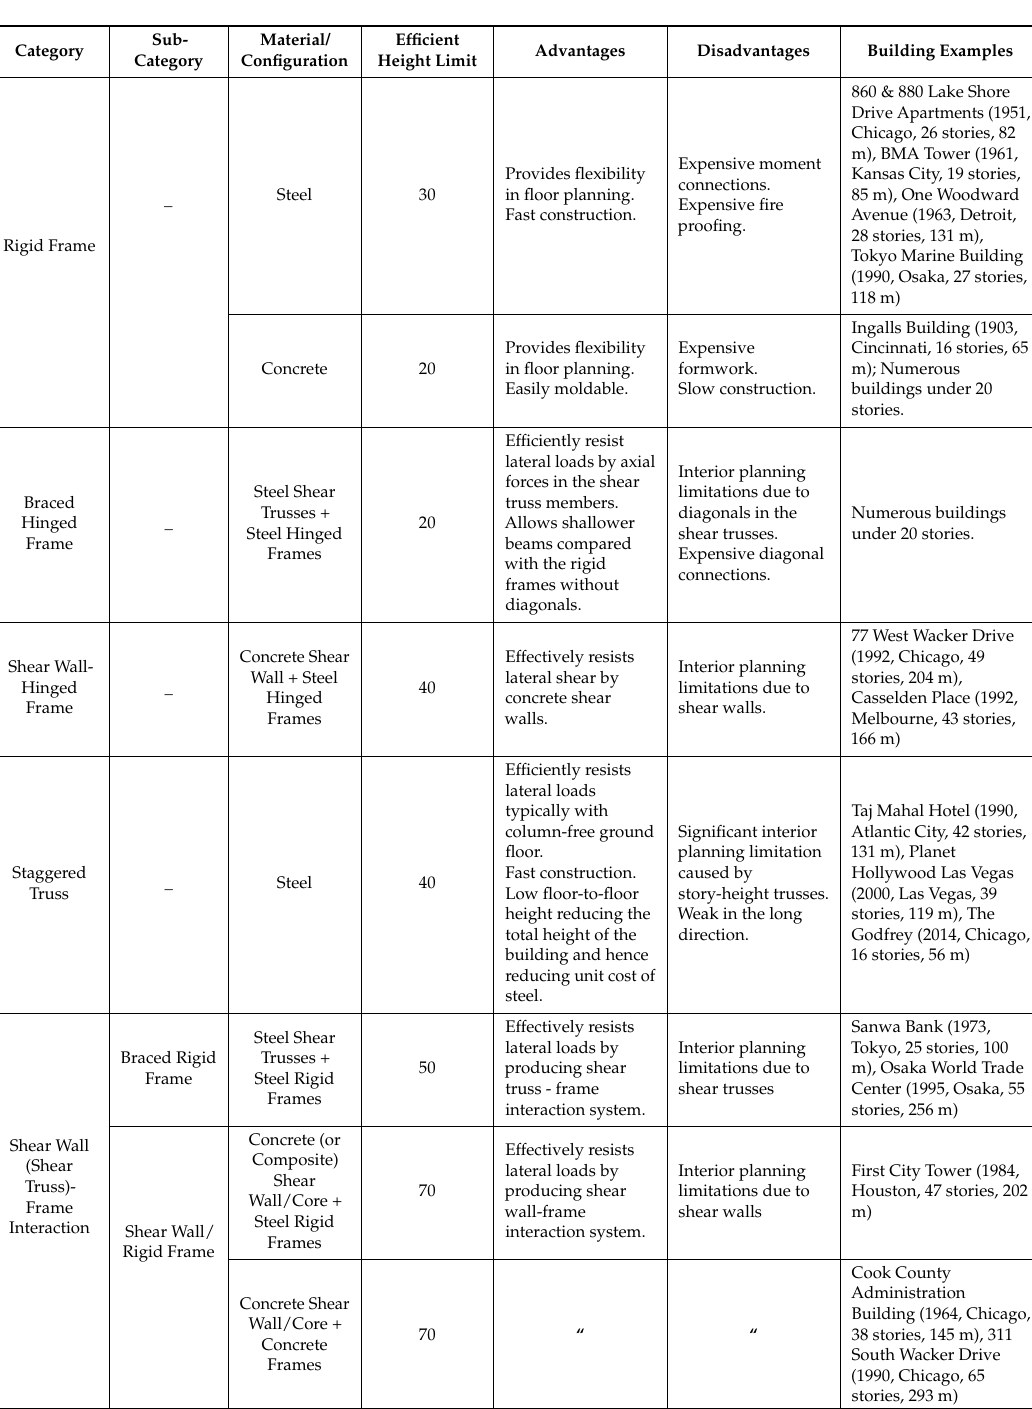
Table 1. Interior